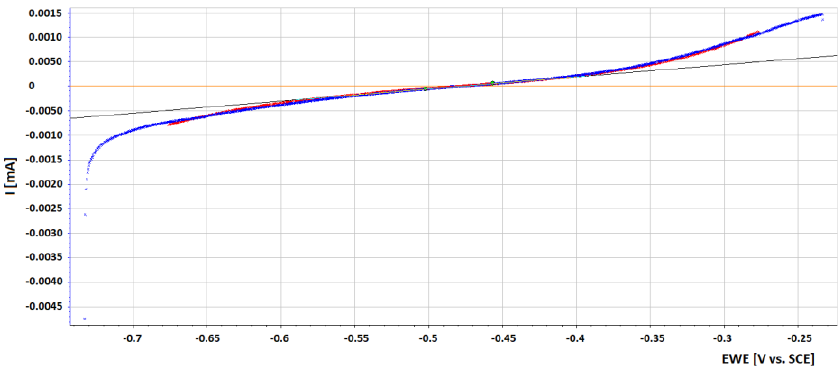
determination of the polarization resistance Rp as the slope of the curve shown in Figure 14 at zero current density. Measurements were performed three times in individual positions on the platform.